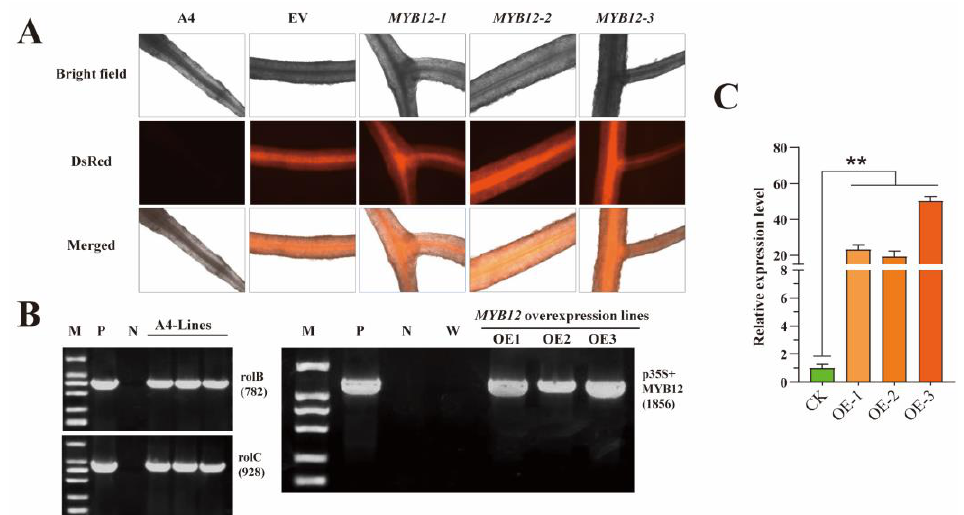
Figure 5. Identification of transgenic hairy roots of S. baicalensis . ( A ) Transgenic hairy root lines and observations with red fluorescent protein. A4: ArA4 lines (negative control); EV: ArA4 strain that harbors the pK7WG2R plasmids (positive control); MYB12 -1~3: SbMYB12 overexpression hairy root lines. ( B ) PCR identification of transgenic hairy roots of S. baicalensis . PCR screening of SbMYB12 overexpressing lines. M: DNA marker (DL2000); P: ArA4 strain containing recombinant plasmid (positive control); N: S. baicalensis sterile plantlet (negative control); W: wild seedling of S. baicalensis . ( C ) Real-time quantitative PCR analysis of SbMYB12 in transgenic lines. CK1-3: ArA4 lines; OE1–3: SbMYB12 overexpression transgenic line; ** represents significant difference ( p < 0.01) via Student’s t -test.